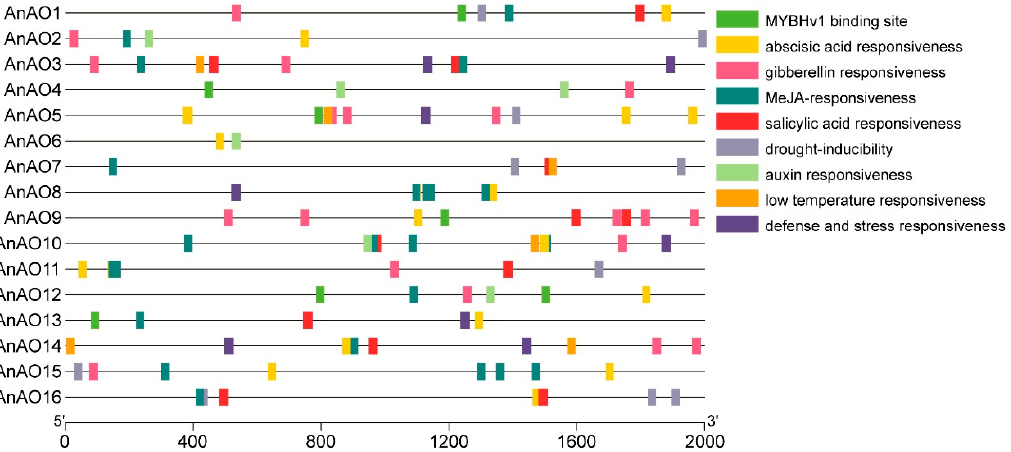
Figure 4. Distribution of the predicted cis-acting elements that were involved in abiotic stress response and hormone response in the promoter region of the AO family genes in A. nanus . Different color blocks represent different types of cis-acting elements.